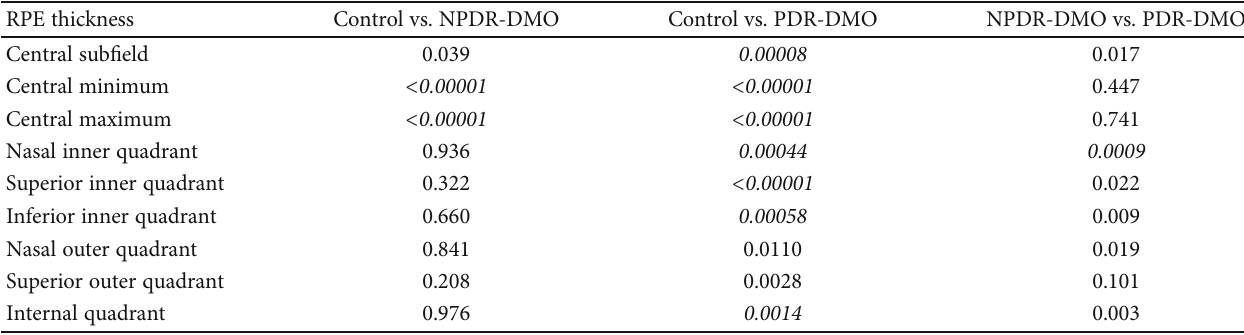
Figure 3: Mean RPE layer thickness di ff erence (%) between the eyes from the control group and NPDR-DMO or PDR-DMO. Table 3: Post hoc analysis for ETDRS quadrants with a statistically signi fi cant di ff erence after the Kruskal-Wallis test. RPE thickness Control vs. NPDR-DMO Control vs.